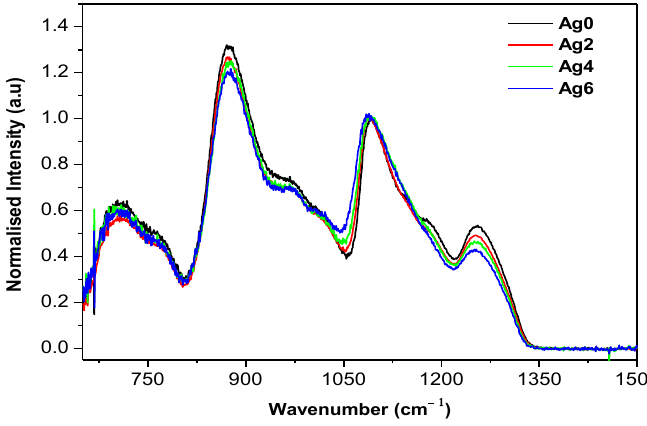
Figure 1. The IR absorption spectra of the investigated glasses.